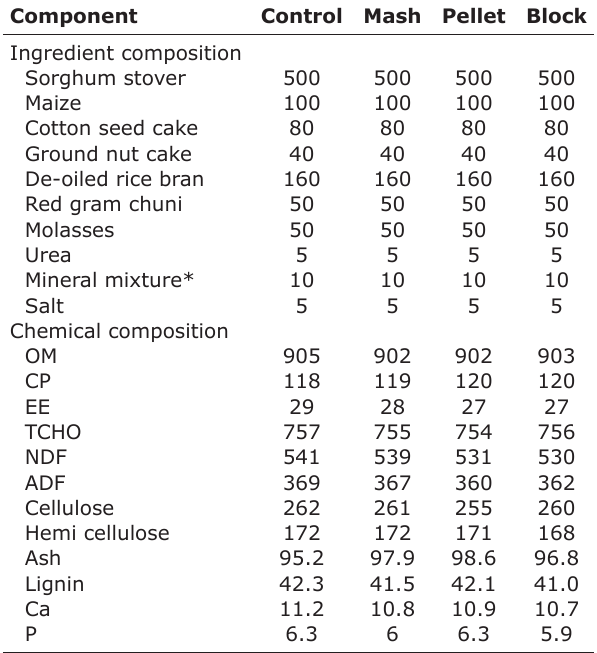
Table-1: Ingredient and chemical composition (g kg -1 ) of differently processed sorghum stover based complete rations for growth study in